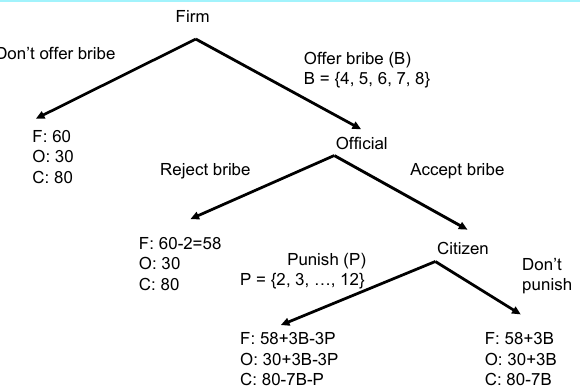
Figure 1: The Structure of the Experiment